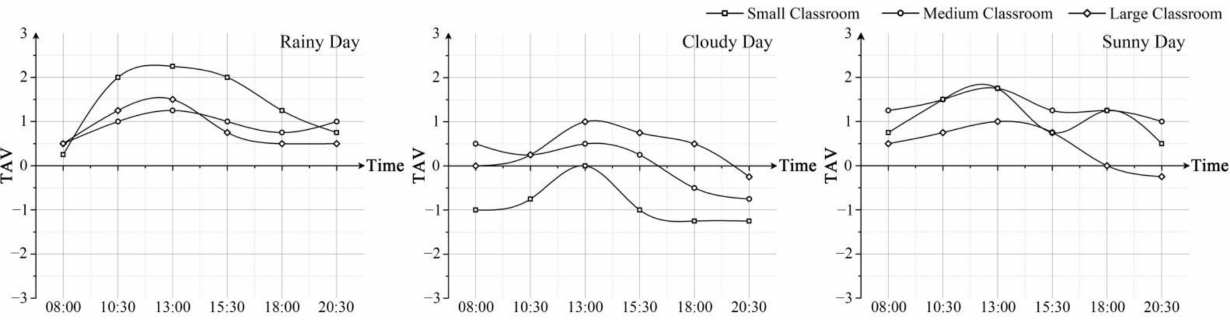
Figure 11. The TAV of the tested students in the three classroom-types under different weather conditions throughout the